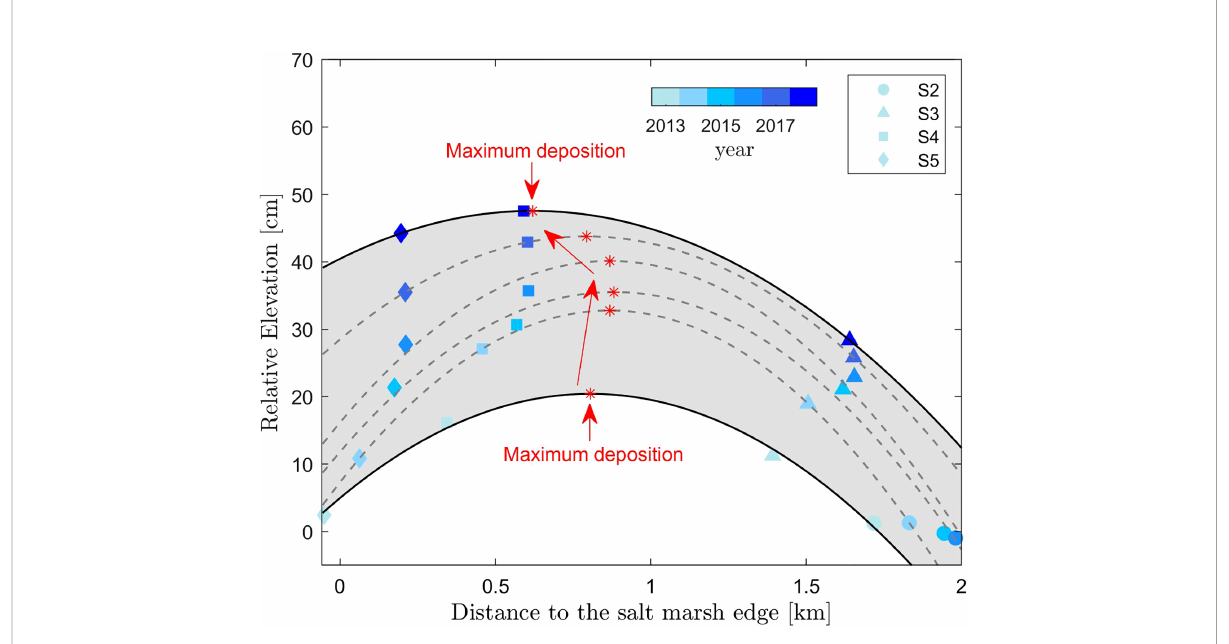
FIGURE 6 The relative soil surface elevation as a function of distance to the salt marsh edge. The shade highlights the changes in the soil surface elevation from 2012 to 2018 at sites S2-S5. The soil surface elevation is relative to that in 2012. Dashed lines and solid lines show the parabolic fi tting of all the relative elevations in each year. Red stars highlight the maximum deposition position in each year and the variation trend is highlighted by red